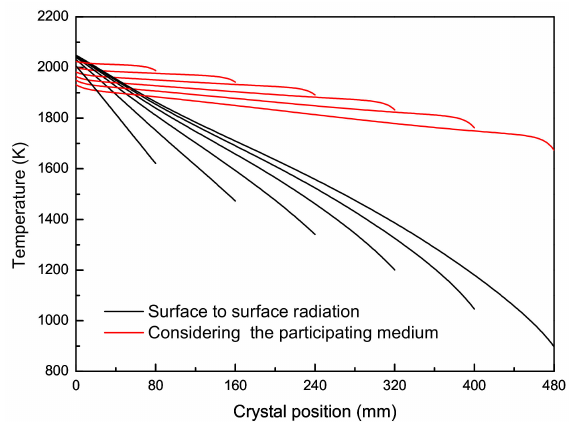
Figure 7. The crystal temperature during the dynamic growth process to help us consider the participating medium and the surface to surface radiation.